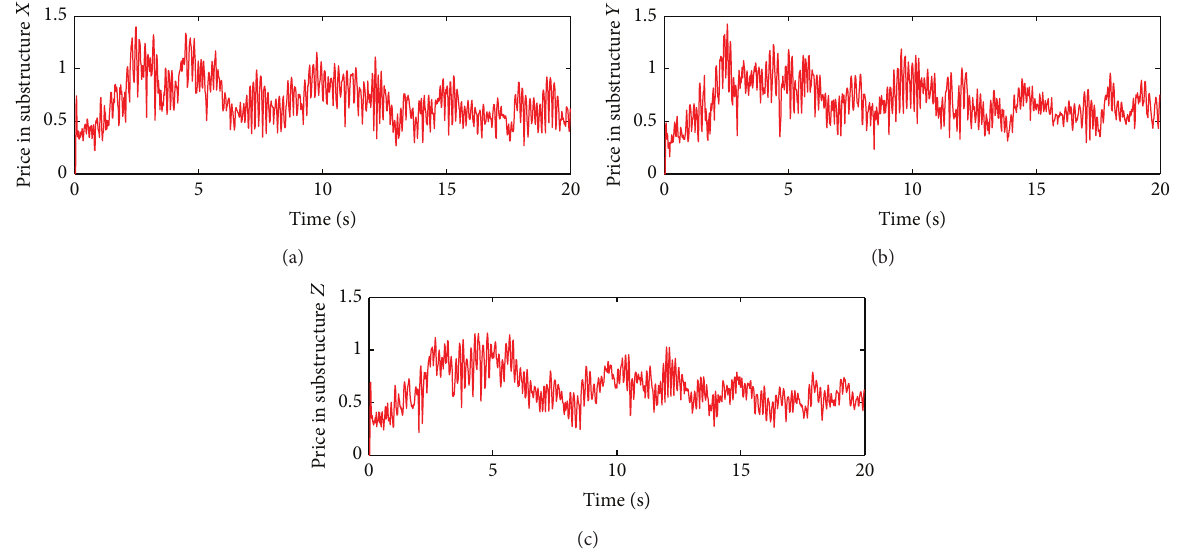
Figure 20: Price time history of